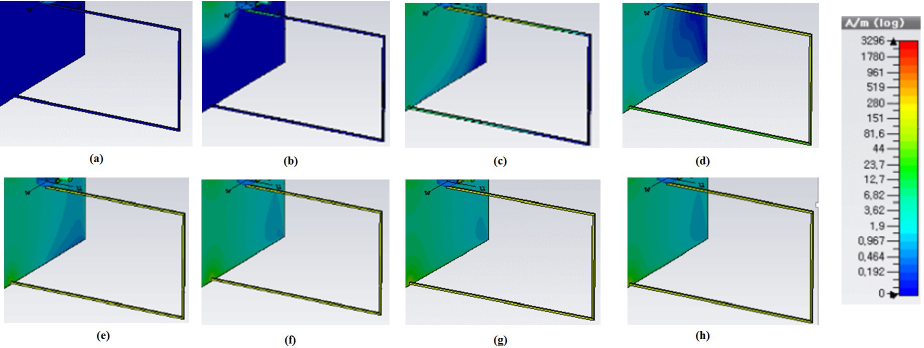
Figure 6. Enlarged current distribution of ground strap from Figure 5: ( a ) 0 ns; ( b ) 1 ns; ( c ) 2.5 ns; ( d ) 4.5 ns; ( e ) 7 ns; ( f ) 20.5 ns; ( g ) 30 ns; and ( h ) 50